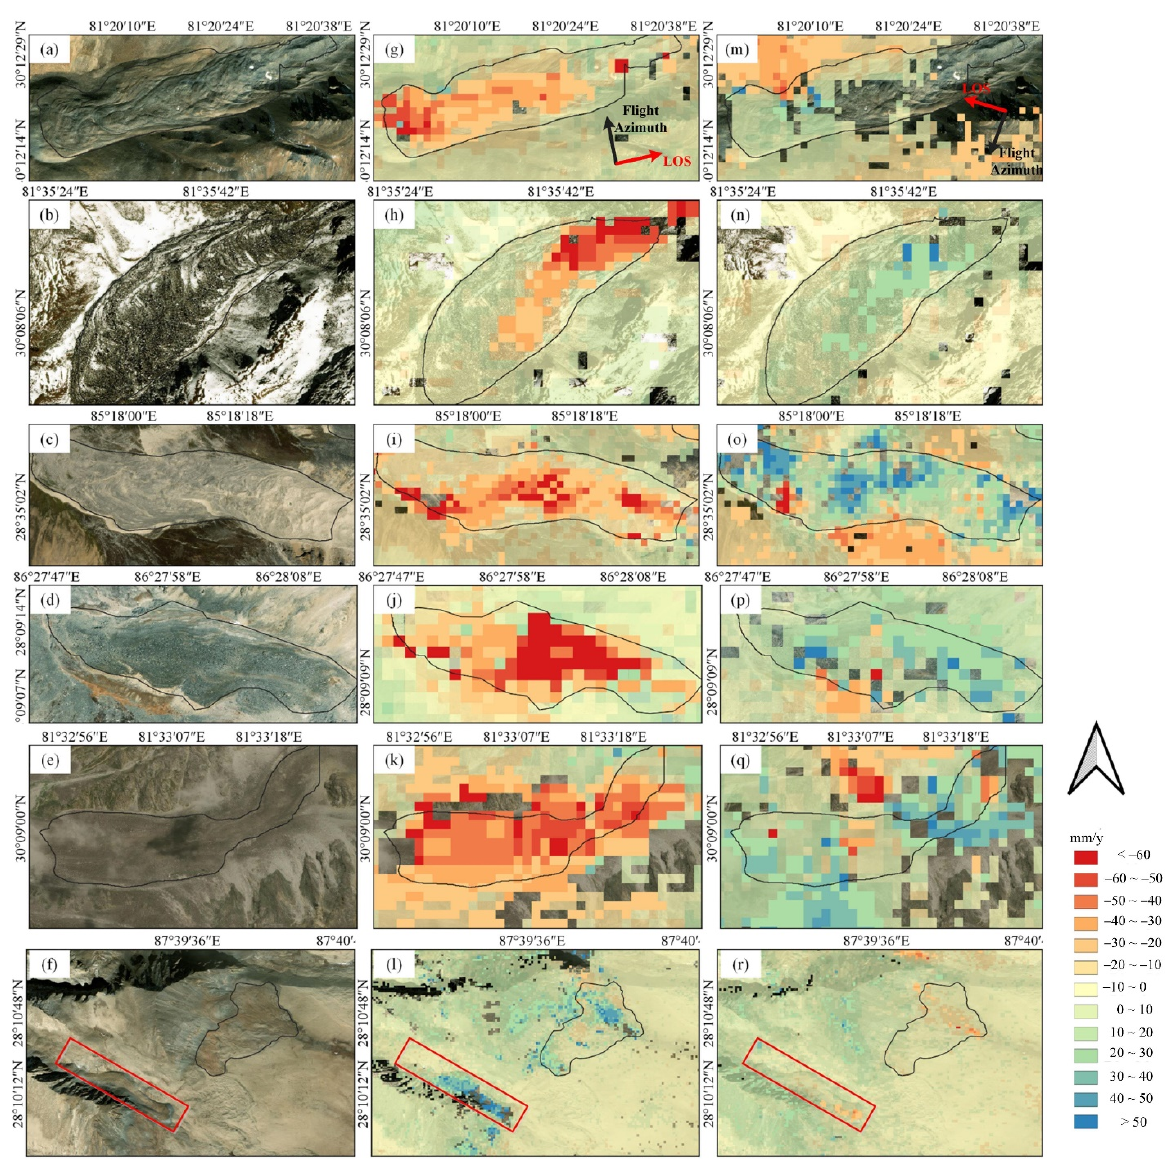
Figure 9. Zoom-in view of typical single rock glacier deformation characteristics in ascending and descending geometries. ( a – f ) Bing optical images of typical rock glaciers. ( g – l ) Typical single rock glaciers deformation in ascending geometry. ( m – r ) Typical single rock glaciers deformation in descending geometry.